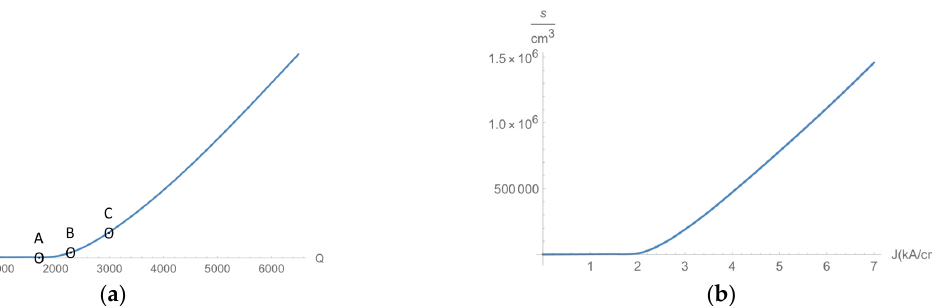
Figure 4 . Simulated time-integrated photon density versus ( a ) the cavity quality factor Q and ( b ) the applied electrical current density J . In ( a ) the pump current is 2.0 kA/cm 2 and the points A, B, C correspond to the cases of Figure 5a–c, respectively; in ( b ) the quality factor is 2000 ( κ CAV ~ 9 × 10 11 s − 1 ). The duration of the pulse is 20 ns; the parameter values are for the validated case in Figure 3 and β sp = 3 × 10 − 4